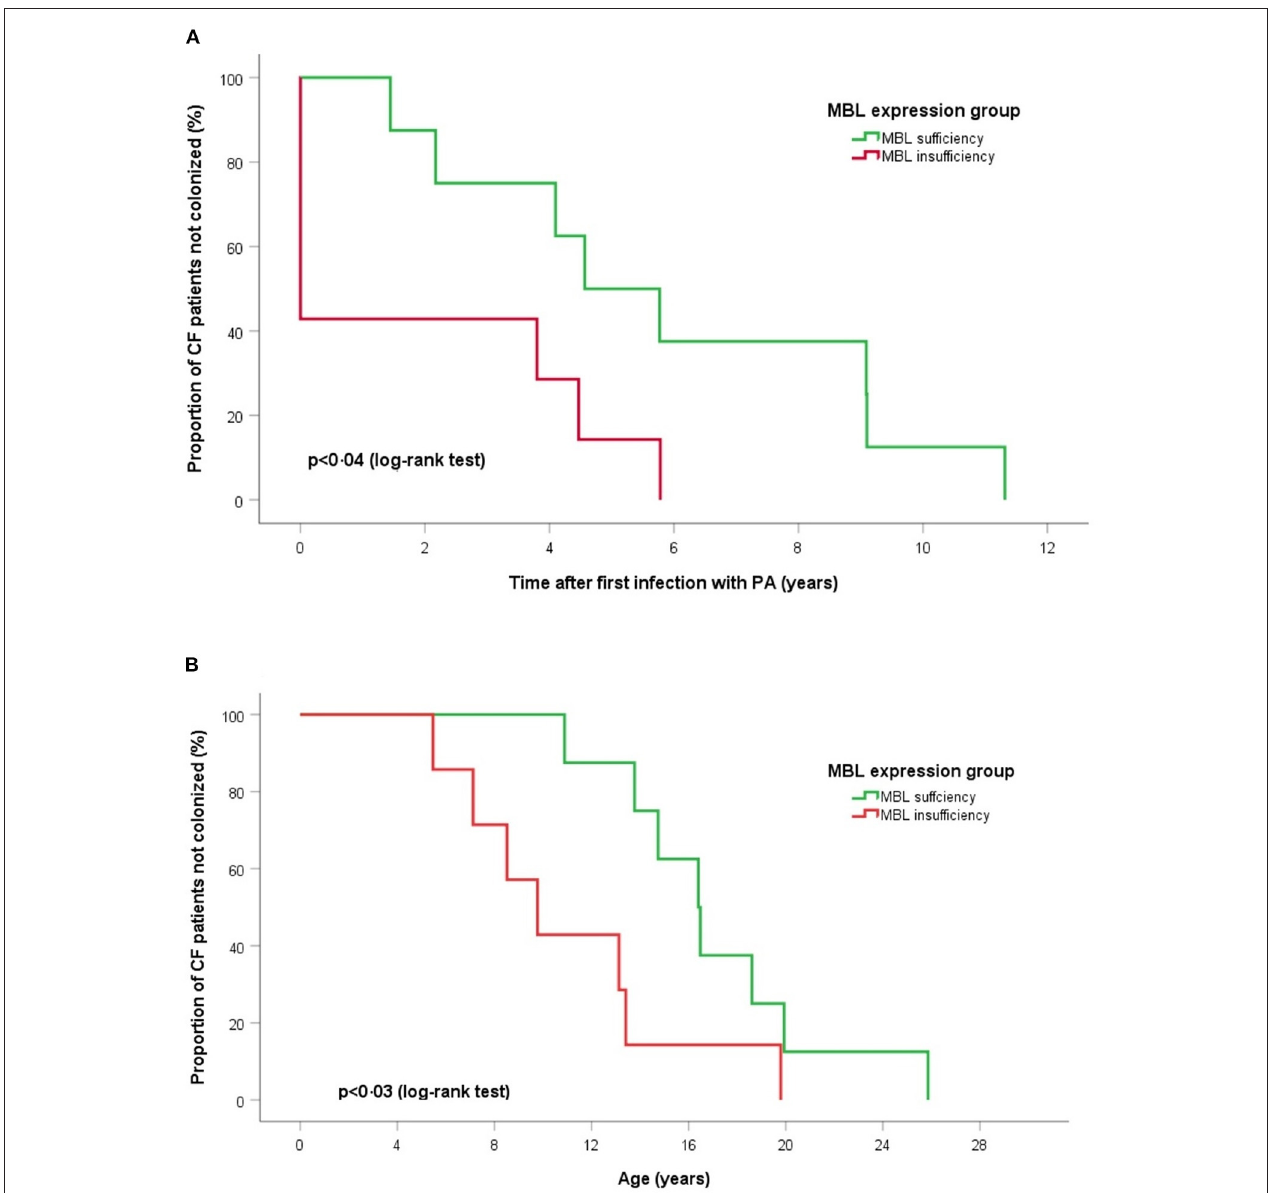
FIGURE 1 | Log-rank tests and Kaplan-Meier curves of time for chronic PA infection according to MBL expression groups. (A) Time after first PA acquisition and (B) age of onset chronic PA colonization. Log-rank tests show for MBL sufficient producers a significant longer duration between first acquisition and start of PA colonization ( p < 0.04) and an older age at onset of chronic PA infection ( p <